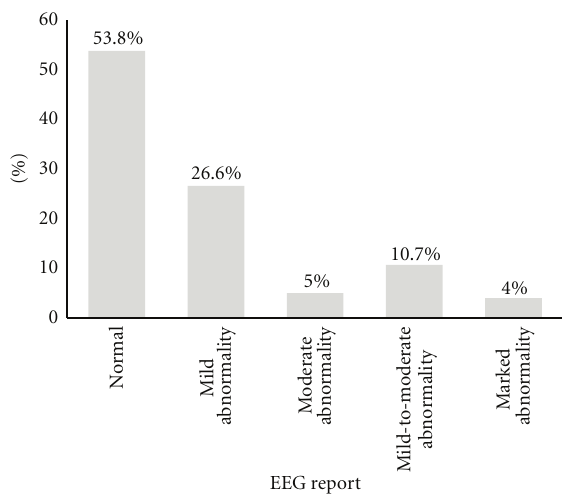
Figure 1: Percentage classification of di ff erent disorders in elec- troencephalography report among study